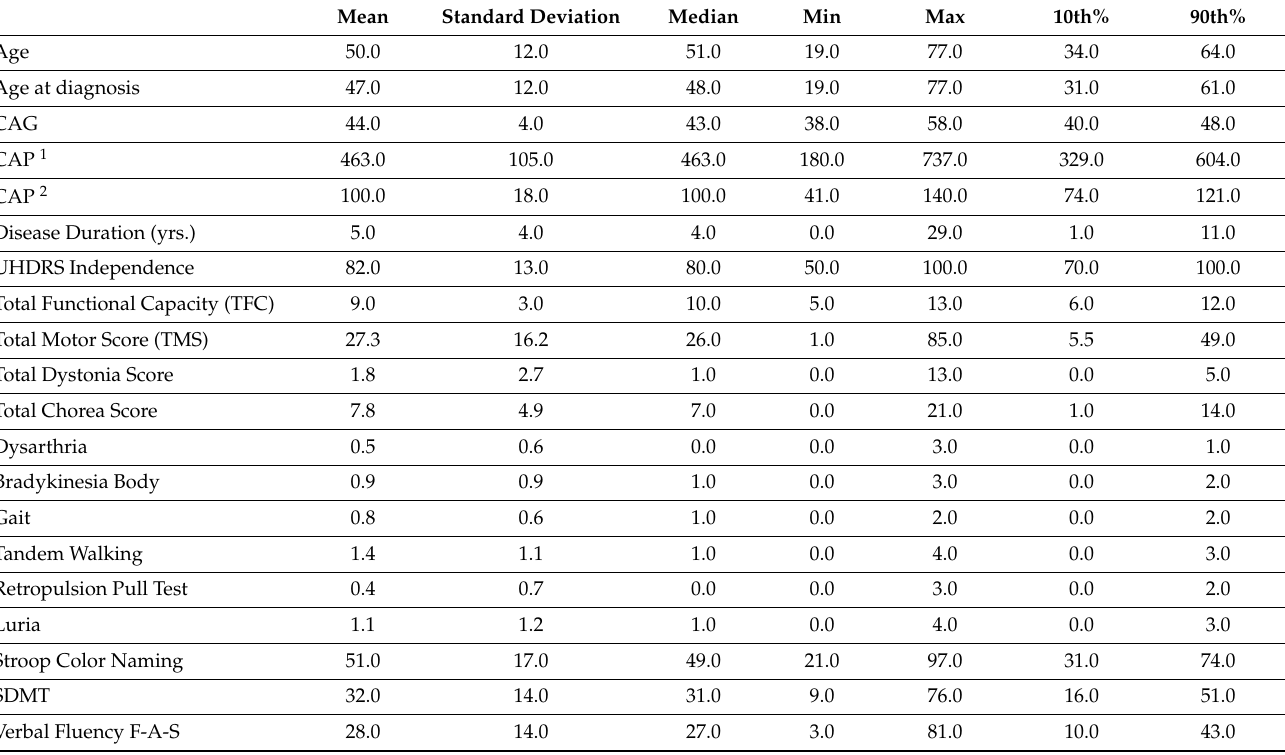
Table 1. Patient characteristics at baseline, (n =